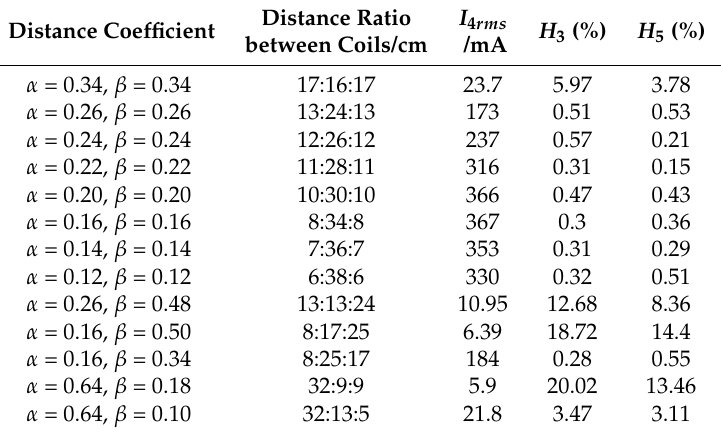
Figure 14. Experimental result of the MCR-WPT system with two intermediate coils—when α = β = 0.2, and the transfer distance is 0.5 m. Table 4. The experimental results of the MCR-WPT system with intermediate coil-1,-2, when the transfer distance D = 0.5 m and the R L = 50 Ω